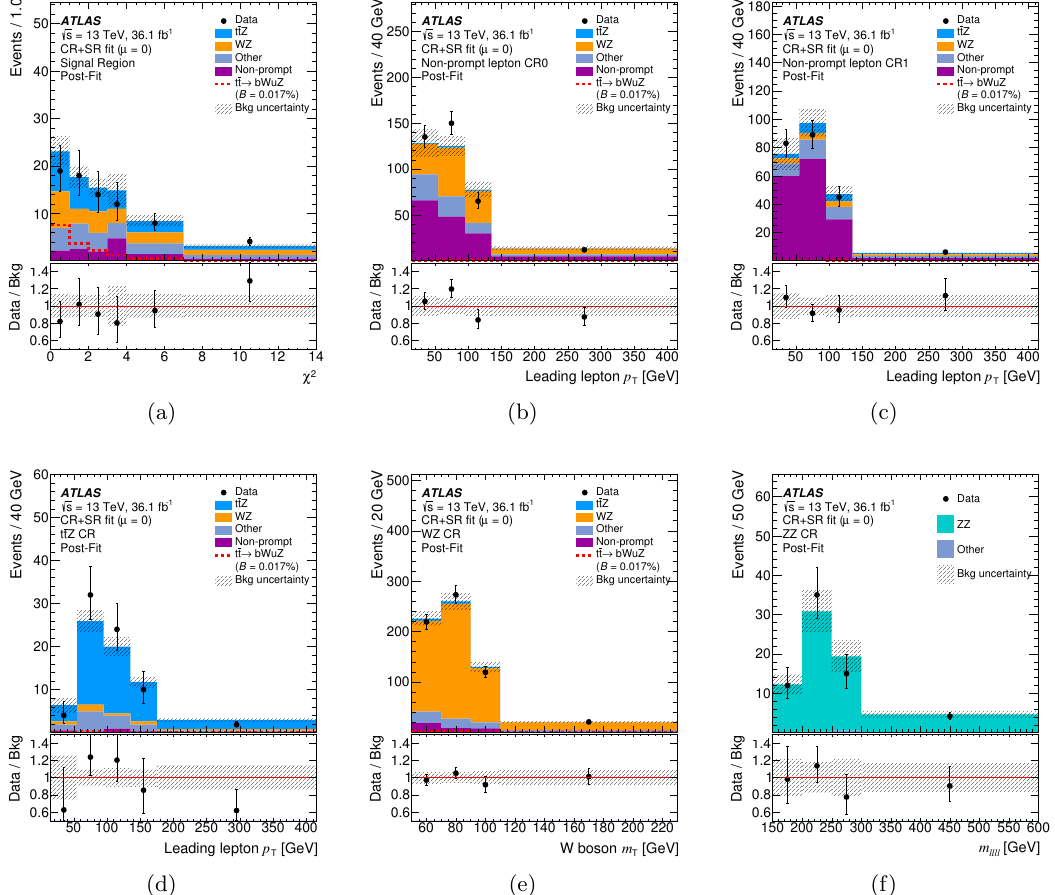
Figure 3 . Expected ((cid:12)lled histogram) and observed (points with error bars) distributions after the combined (cid:12)t under the background-only hypothesis of (a) the (cid:31) 2 of the kinematical reconstruction in the SR; (b) p T of the leading lepton in the non-prompt lepton CR with b -tag veto; (c) p T of the leading lepton in the non-prompt lepton CR with b -tag; (d) p T of the leading lepton in the t (cid:22) tZ CR; (e) the transverse mass in the WZ CR and (f) the reconstructed mass of the four leptons in the ZZ CR. For comparison, distributions for the FCNC t (cid:22) t ! bWuZ signal (dashed line), normalized to the observed limit, are also shown. The \Other" category includes all remaining backgrounds described in section 3. The dashed area represents the total uncertainty in the background